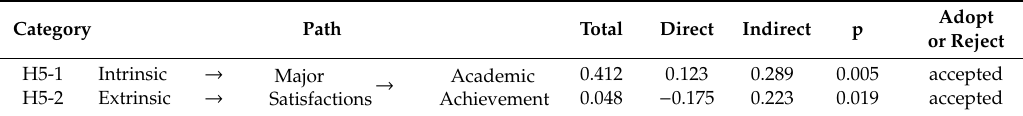
Table 6. Result of Analyzing the Mediating E ff